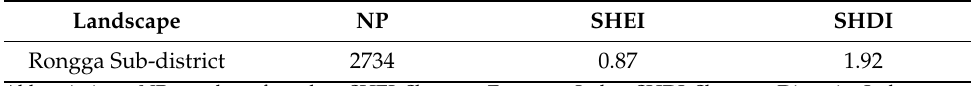
Table 10. Calculation results of NP, SHEI, and SHDI metrics at the landscape level. Landscape NP SHEI SHDI Rongga Sub-district 2734 0.87